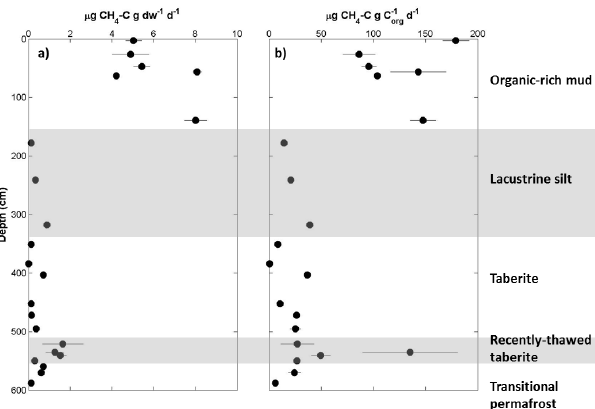
Figure 6. Depth profile for CH 4 production potentials in the Vault Lake core. Samples were anaerobically incubated at 3 ◦ C. Methane production potentials are represented as mean value ± SD among replicates and normalized per gram dry weight sediment (a) and per gram organic carbon (C org ; b